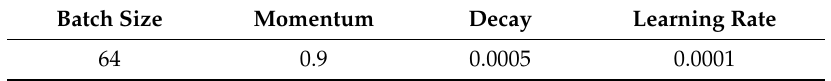
Table 2. The initial values of the parameters in training the excavator detection model.